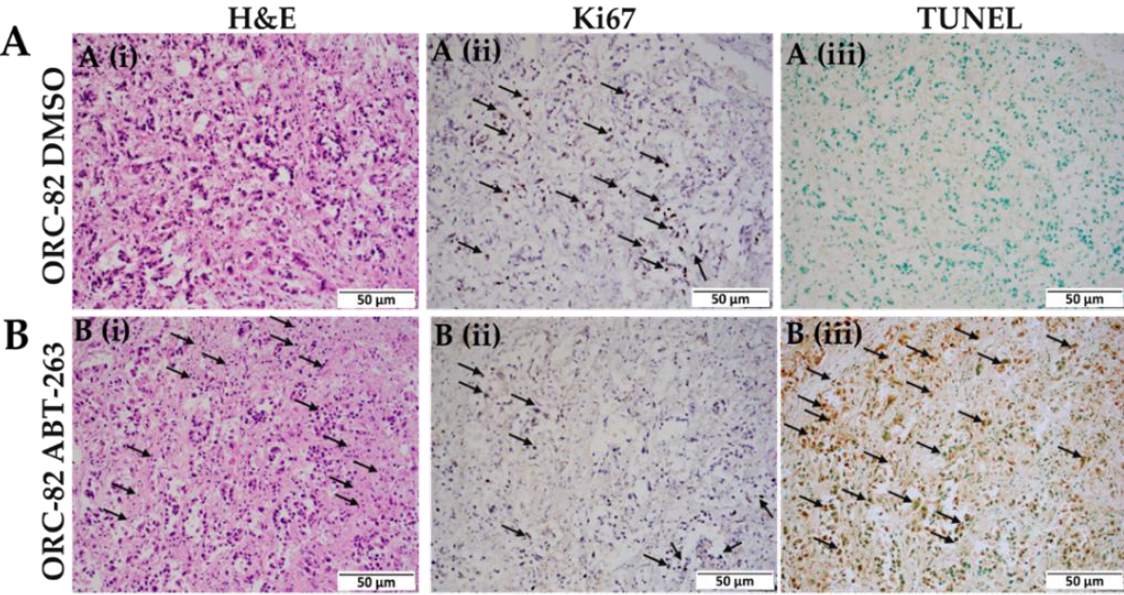
Figure 6. ABT-263 treatment induces apoptosis. Top panel ( A ) shows ( A ( i )) H&E, ( A ( ii )) Ki67 staining, and ( A ( iii )) TUNEL staining in ORC-82-DMSO, and bottom panel ( B ) shows ( B ( i )) H&E, ( B ( ii )) Ki67 staining, and ( B ( iii )) TUNEL staining after ABT-263 treatment (ORC-82-ABT-263). Arrows in ( B ( i – iii )) show high numbers of dying cells, and ( B ( ii )) shows reduced cell proliferation. All images at 20× magnification, (scale bar: 50 µm).